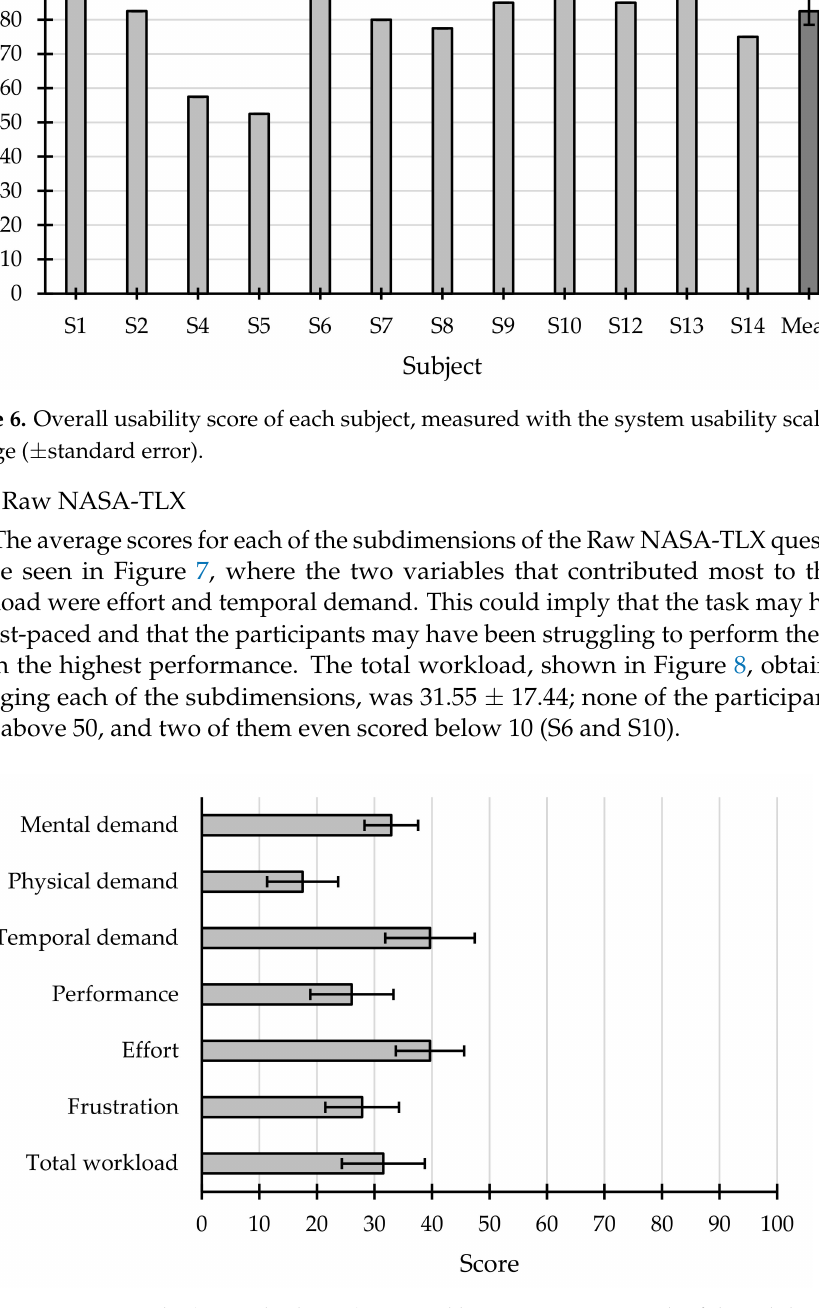
Figure 7. Average results ( ± standard error) reported by participants in each of the subdimensions of the Raw